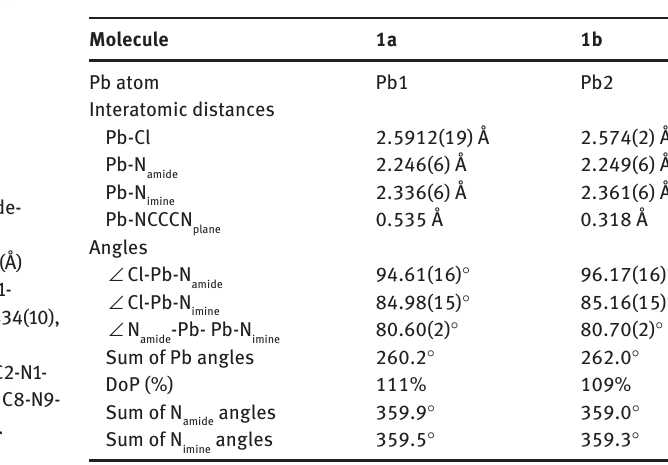
Table 1: Comparison of interatomic distances and angles in the two similar but independent molecules 1a and 1b in the molecular